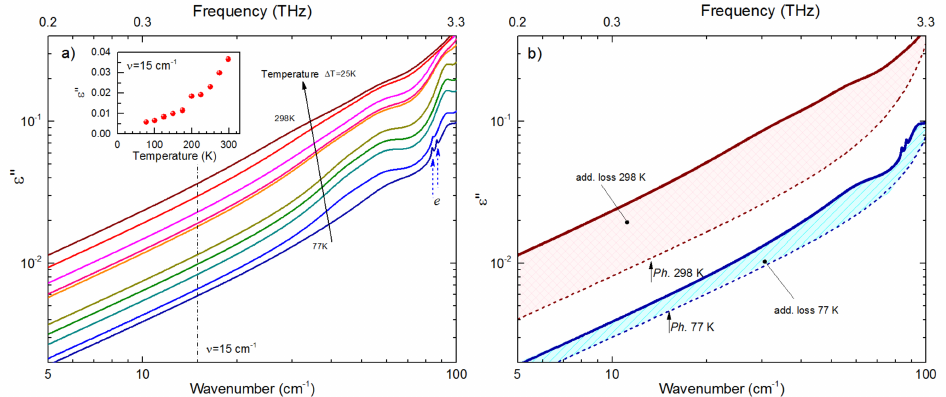
Figure 6. Temperature evolution of ε ”( ν ) spectra in the THz frequency range. Solid lines on graphs ( a , b ) indicate the total level of the dielectric losses, obtained using THz transmission spectra. Dashed lines on graph ( b ) indicate the level of dielectric losses determined by the contribution of optical phonon contours at temperatures of 298 and 77 K. The shaded areas show additional losses (add.loss) with respect to one-phonon